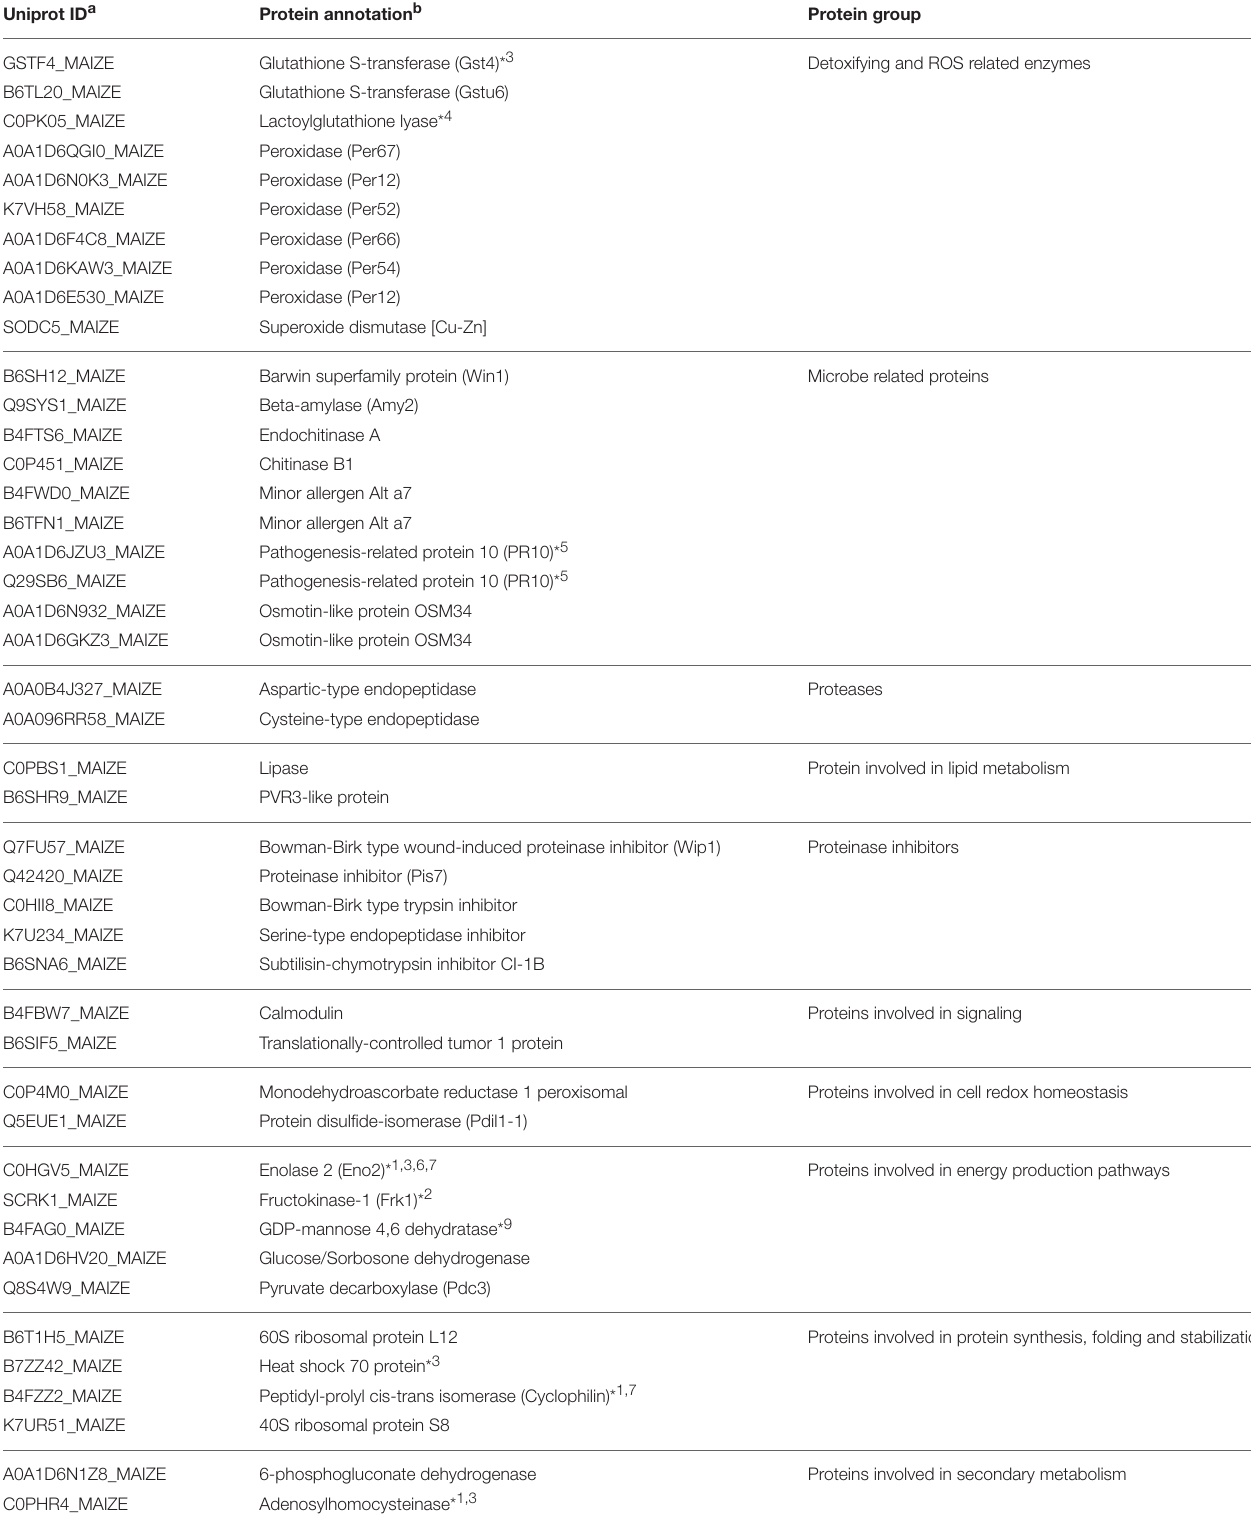
TABLE 1 | Summary of the apoplastic proteins secreted by Zea mays after 5 days interaction (inoculated). Uniprot ID a Protein annotation b Protein